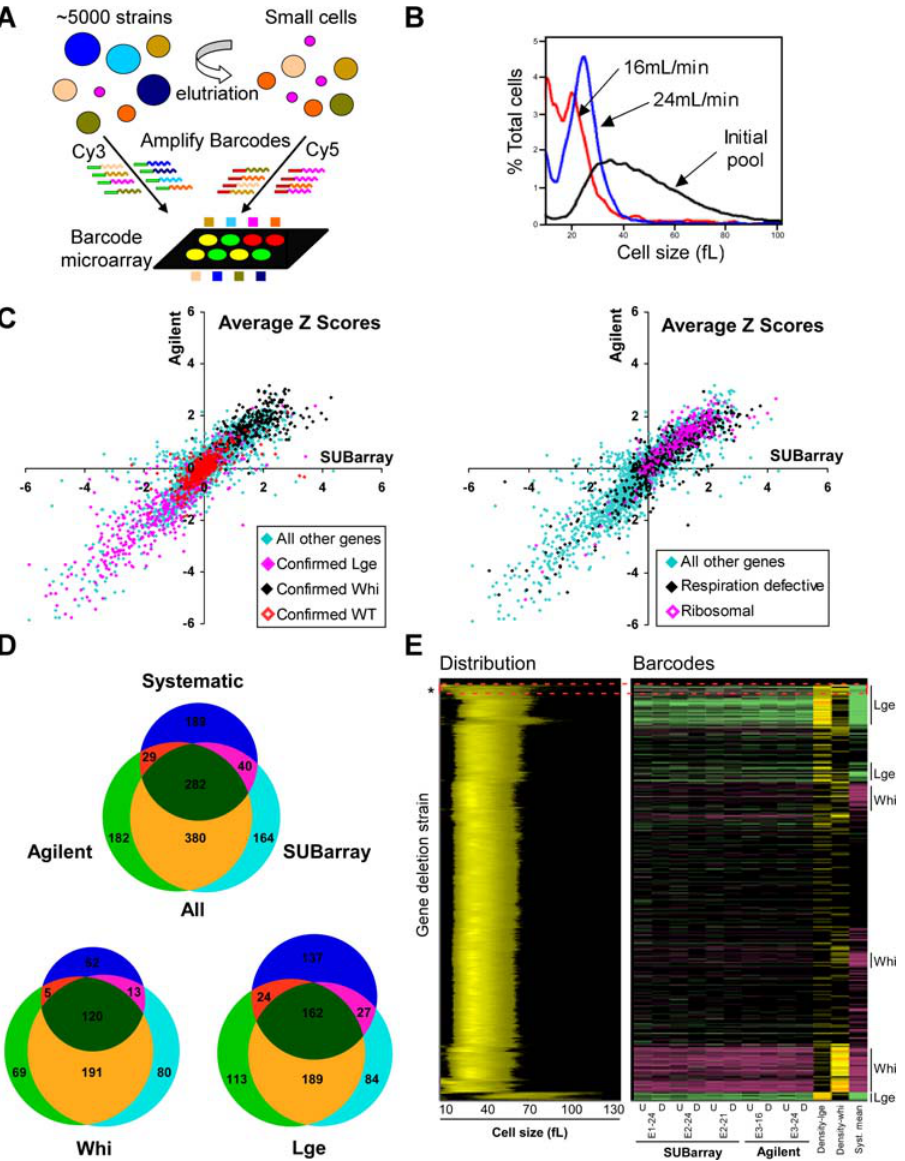
Figure 3. Barcode elutriation cell size experiment. A. Schematic of the experiment. Elutriation of the haploid pool enriches for small cells. Genomic DNA is isolated from cell populations immediately before and immediately after elutriation, differentially labeled with either Cy5 or Cy3, and applied to a barcode microarray. B. Cell size distributions of a characteristic elutriation as determined by use of a Coulter Z2 particle analyzer (Beckman). Increasing the rate of flow through the elutriation rotor increases the median cell size of the elutriated fraction. C. Scatter plot of the average barcode Z score. Agilent (Y axis). SUBarray (X axis). Left. Overlay of barcodes of strains confirmed as either lge (black), whi (magenta), or wild- type (WT; red) by systematic experiments [28] on all other barcodes (blue). Right. Overlay of barcodes of structural components of the cytosolic or mitochondrial ribosome (magenta) or respiration defective strains [32] (black) on all other barcodes (blue). D. Venn diagrams of overlap between systematic and barcode data using SUBarrays or Agilent arrays. Cell size mutants are as defined in the text. E. Overlap between systematic and barcode data. Clustered cell size distributions are represented by horizontal bars color coded by intensity to reflect the shape of the distributions, with deletion strains on the vertical, and cell size on the horizontal axis. Barcodes, divided into UP (U) and DN (D) tags, with Z scores greater than 1 are represented as Lge (green bars) or Whi (red bars) adjacent to their cognate deletion strain for all experiments (E1, E2, E3) and all elutriation cuts (16, 21, 24 mL/min). SUBarrays and Agilent arrays are shown. The density of lge or whi barcodes (Z score . 1) over a 3 gene window is represented by horizontal bars color coded by intensity ( . 10% brown; . 30% yellow; . 70% orange). Only barcodes with significant intensity/SNR were used in density calculations. Gene deletion strains with systematic mean cell sizes . 1 SD larger (green) or smaller (red) than average are shown. Systematic lge strains with broad distributions and unexpected cell size by barcode are indicated (dotted red box and asterisk).